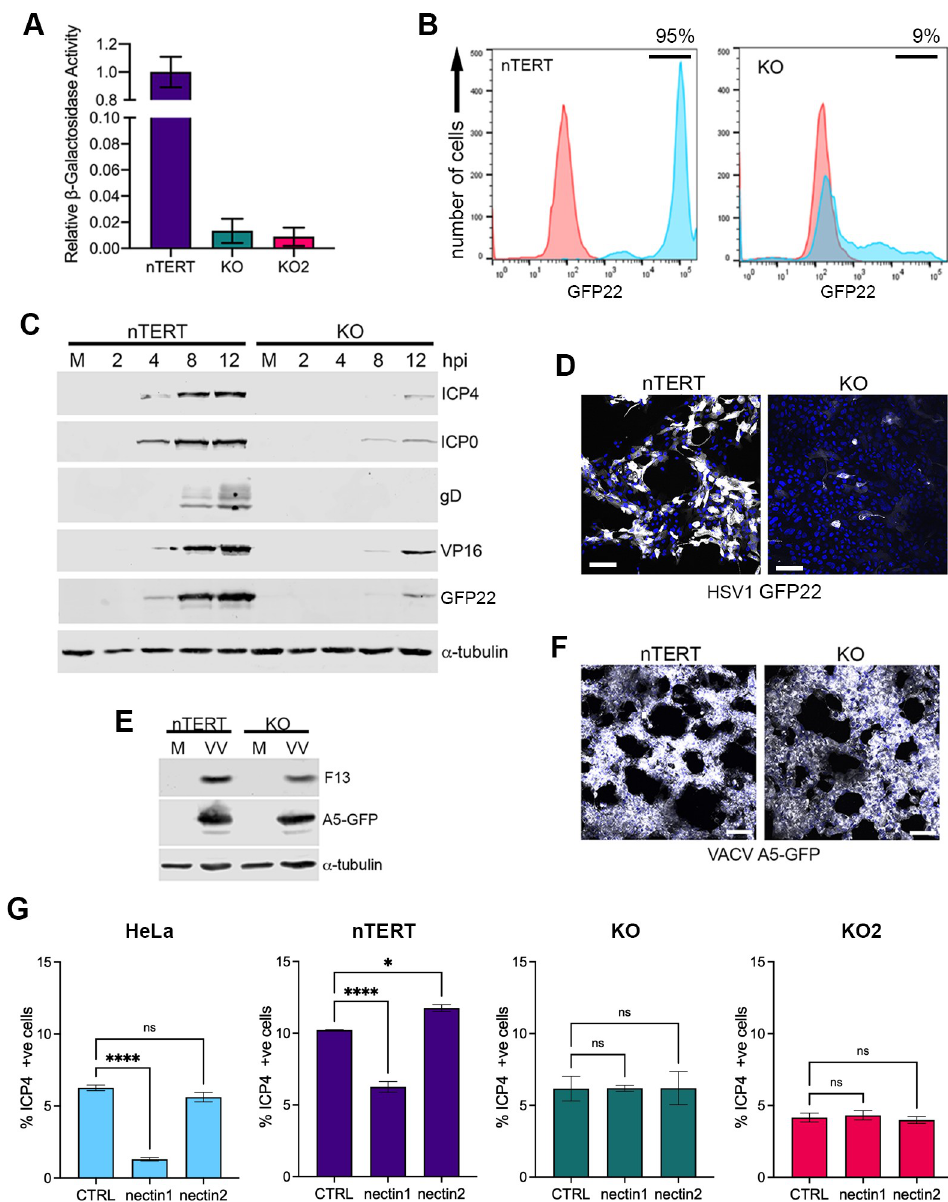
Fig 2. HSV1 infection of nectin1 KO cells. (A) nTERT, KO and KO2 cells were infected at MOI 5 with HSV1 IE110 lacZ on ice to allow attachment, before shifting to 37˚C for 3 h, and β -gal activity was measured by ONPG assay (mean ± SEM, n = 3). (B) nTERT and KO cells were infected with HSV1 expressing GFP22 at MOI 5, and fixed 8 h later. Uninfected (red) and infected (blue) cells were analysed for GFP fluorescence by flow cytometry. Percentages refer to proportion of cells with GFP > 10 4 fluorescence intensity. (C) nTERT and KO cells were infected with HSV1 GFP22 at MOI 5, harvested at the indicated times and analysed by SDS-PAGE and Western blotting for a range of virus proteins as indicated, and α -tubulin as a loading control. (D) nTERT and KO cells grown on coverslips were infected with HSV1 GFP22 at MOI 5, fixed at 8 h, stained with DAPI (blue) and analysed by confocal microscopy for GFP fluorescence (white). Scale bar = 100 μ m. (E) nTERT and KO cells were infected with VACV expressing A5GFP at MOI 5, harvested at 16 h and analysed by SDS-PAGE and Western blotting for F13 and GFP. (F) nTERT and KO cells grown on coverslips were infected with VACV as in (E), fixed, stained with DAPI (blue) and analysed by confocal microscopy for GFP fluorescence (white). Scale bar = 100 μ m. (G) HeLa, nTERT, KO or KO2 cells were pre-incubated with no antibody (CTRL) or 10 μ g nectin1 or nectin2 antibody. Cells were then infected with HSV1 GFP22, acid washed, fixed at 4 h and stained with DAPI. GFP positive cells were counted and expressed as a percentage of total DAPI counts (mean ± SEM, n = 3). � , P < 0.05; ���� , P < 0.0001; ns, non-significant (by one-way analysis of variance